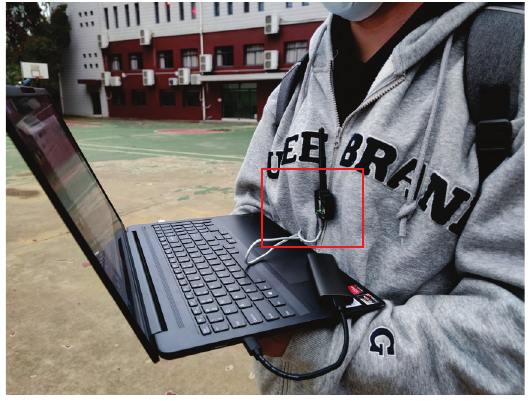
Figure 6 . UWB tag installation.